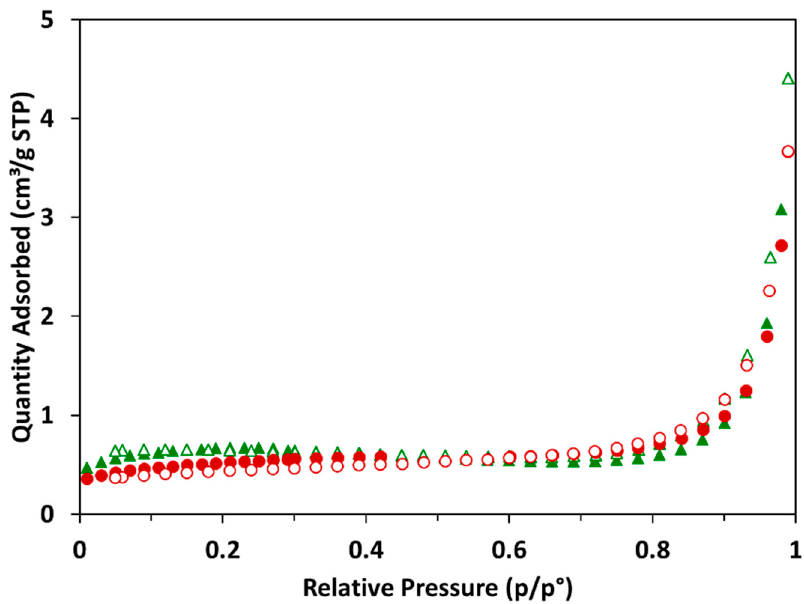
Figure 3. Nitrogen isotherms of catechol-HCP-w (green triangle) and catechol-HCP-Fe (red circle). The closed and open symbols represent the adsorption and desorption isotherms, respectively.